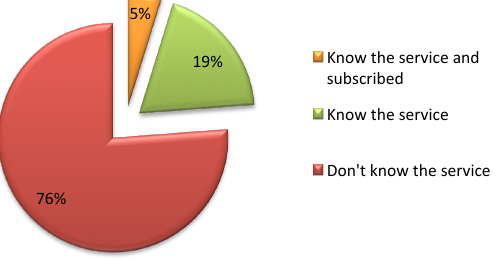
Figure 3. Knowledge of the SMS warning service in